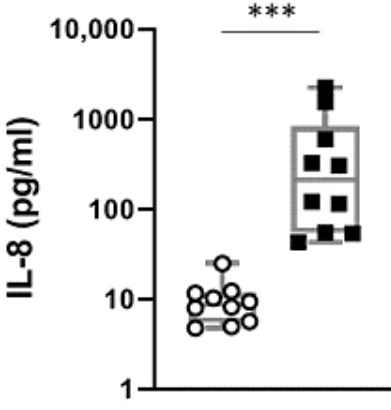
Figure 4. IL-8 was significantly increased in preterm newborns that suffered from infections. The levels of IL-8 were determined in cord blood of preterm born infants that suffered (back squares) or not (white circles) from infections. The results are presented in boxplots indicating the median, percentiles, and maximum and minimum values, whilst the dots depict the individual values. *** p < 0.0001, Mann–Whitney U Test. n = 10.